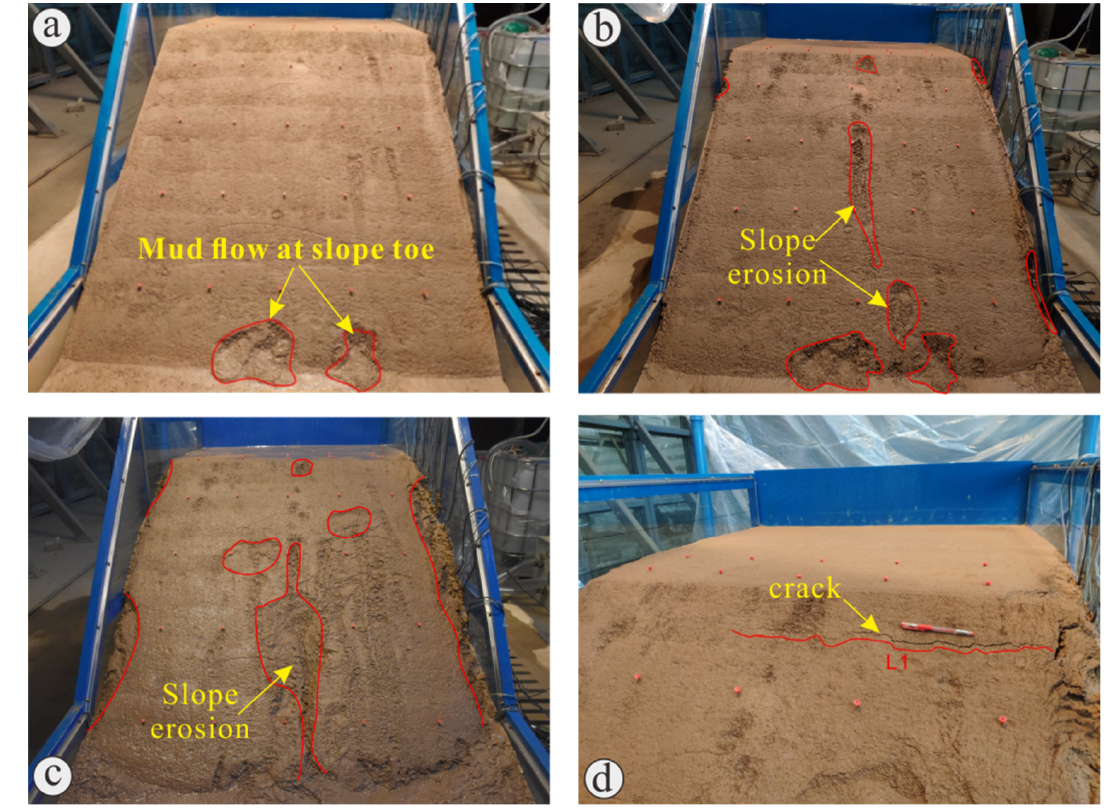
Figure 12. The deformation characteristics and failure process of slope. ( a , b ) Mud flow at slope toe and slope erosion on the first day, ( c ) slope erosion on the second day and ( d ) slope cracks on the third day.